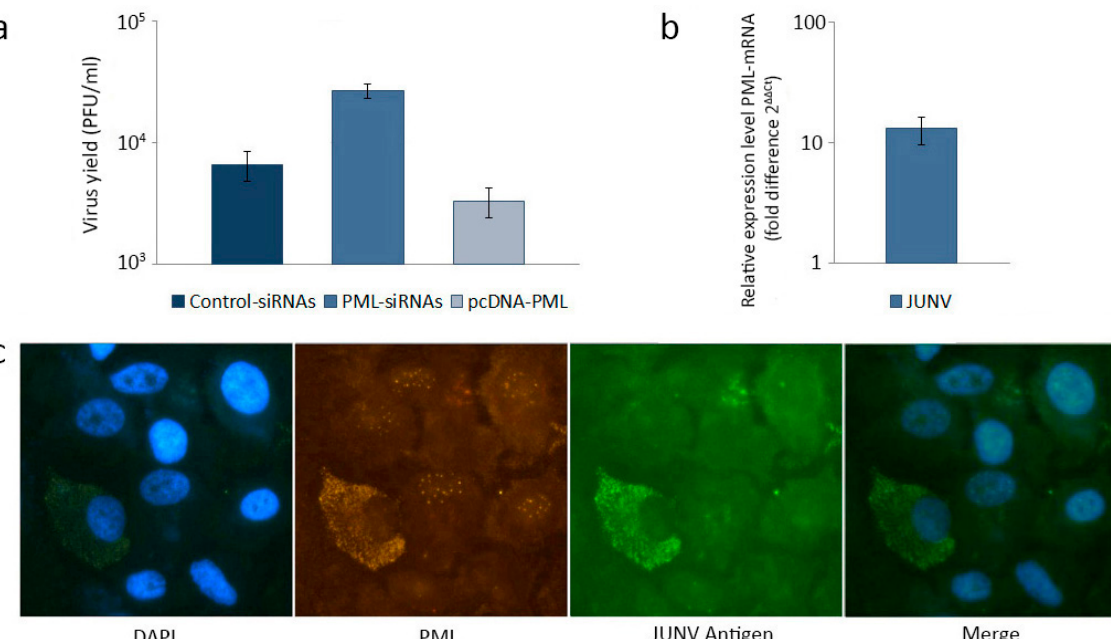
Figure 2. ( a ) Effect of PML on infectious particle production. Control-siRNAs, PML-siRNAs and pcDNA-PML transfected A549 cells were infected with an attenuated strain of JUNV. At 24 h post infection (p.i.) viral yields were determined by a standard plaque assay; ( b ) Determination of PML-mRNA expression levels. JUNV infected A549 cells were harvested at 24 h p.i. for qRT-PCR. PML-mRNA expression was represented as fold difference relative to mock infected cells and normalized to β -actin-mRNA; ( c ) Effect of JUNV infection on PML-NBs distribution. JUNV infected A549 cells were fixed 24 h p.i. and a double immunofluorescence was performed using monoclonal anti-nucleoprotein antibody visualized by fluorescein isothiocyanate and monoclonal anti-PML antibody visualized by tetramethyl rhodamine isothiocyanate. Cell nuclei were stained